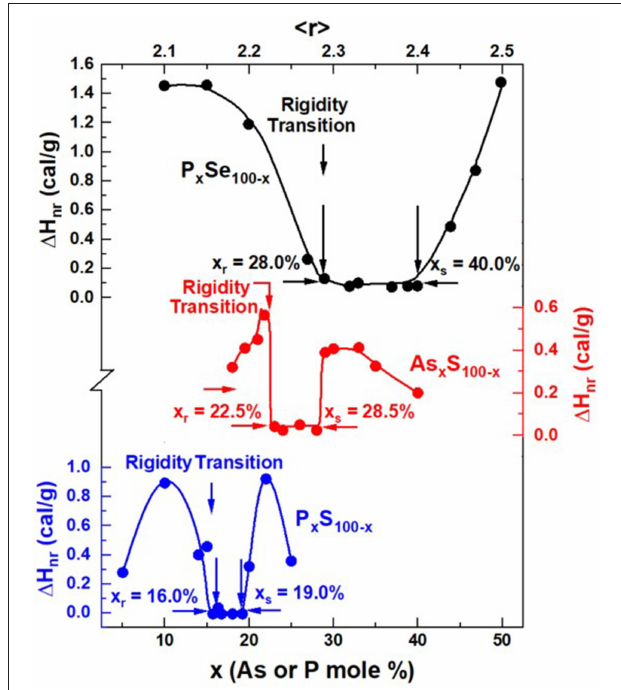
FIGURE 14 | Observed reversibility windows in P x S 100 − x (Vempati, 2005), As x S 100 − x ( Figure 11B , t m = 0, present work), and P x Se 100 − x (Chakravarty et al., 2005 ) glasses. Note that the rigidity transition, x r = 16% in P x S 100 − x , shifts up to x r = 22.5% in As x S 100 − x , and then to x r = 28% in the P x Se 100 − x